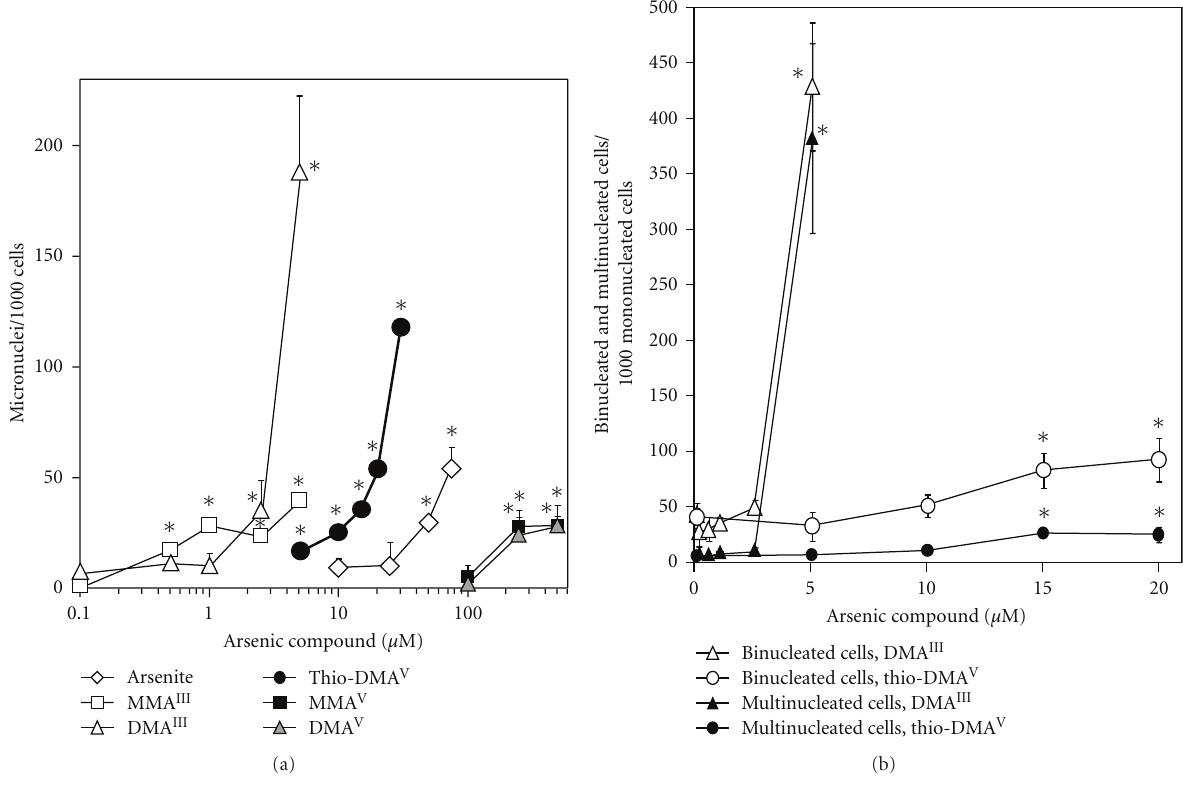
Figure 6: Induction of micronuclei (a), binucleated and multinucleated cells (b) after 24h incubation of A549 cells. After 24h in culture, logarithmically growing A549 cells were treated with arsenite, MMA III , DMA III , thio-DMA V , MMA V , or DMA V for 24h; cells were fixed, stained and finally analysed by fluorescence microscopy as described in Materials and Methods. (a): additionally induced micronuclei, micronuclei level in control was 27 ± 3; (a, b): shown are mean values of at least three independent determinations + SD; statistically significant di ff erent from nonarsenic exposed controls: ∗ P < 0 . 01 as determined by Student’s t